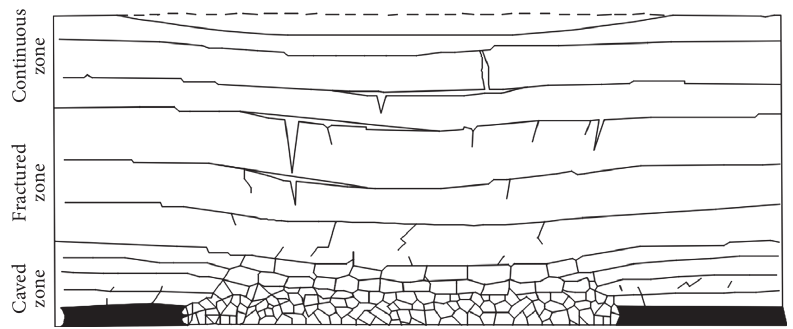
Figure 1: Three key disturbed zones above the longwall panel due to longwall